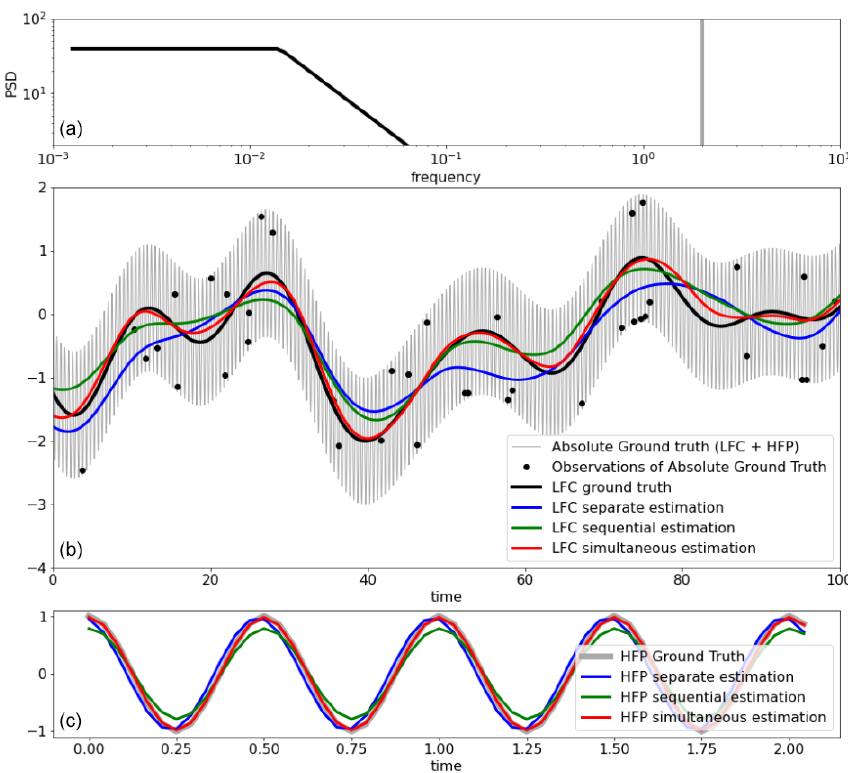
Figure 1. (a) Power spectral density of the ground-truth one-dimensional signal, constituted by a low-frequency continuum (black line) and by a high-frequency peak representing a single harmonic of unitary amplitude. (b) Time series of the ground truth (generated randomly following spectra in (a) ) in gray, with the low-frequency component (LFC) shown by the black line, and its three estimations (in colors as indicated in the legend) from the synthetic observations represented by the black dots. (c) Time series of the high-frequency ground truth with its three estimations (in colors as indicated in the